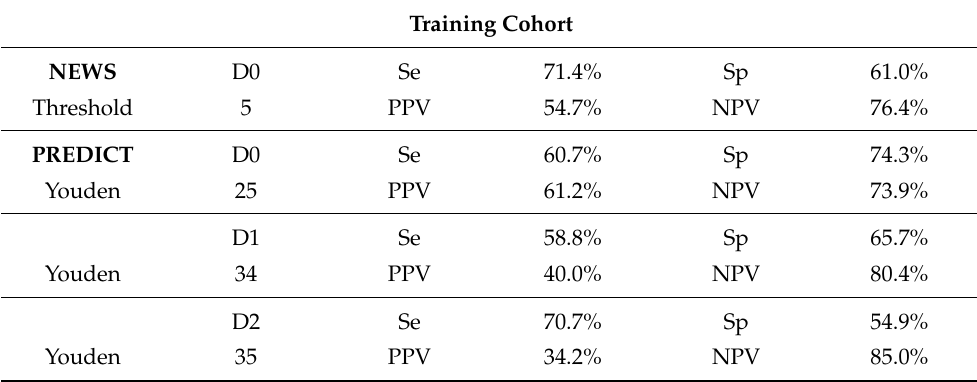
Figure 5. Kinetic follow-up of biological parameters. Left column: Standard Medical Units Patients vs. Standard to Intensive Care Patients. Right column: Standard Medical Units Patients vs. Intensive Care Units Patients. ALB: albuminemia. Table 8. PREDICT and NEWS2 score characteristic comparison for training cohort. Se: sensitivity; Sp: specificity; PPV: Positive Predictive Value; NPV: Negative Predictive